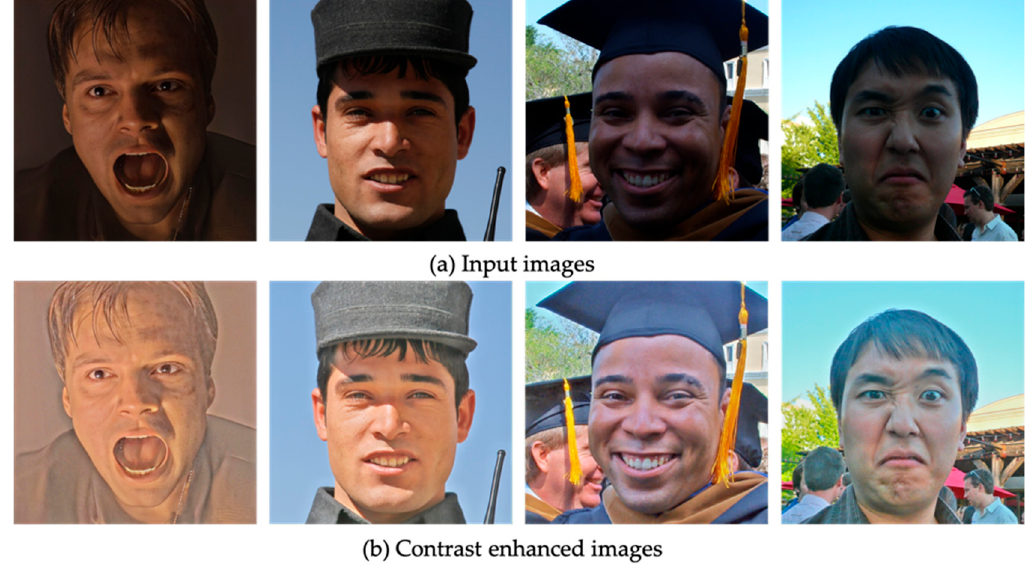
Figure 5. Example images of low-light image enhancement algorithm using AffectNet dataset.